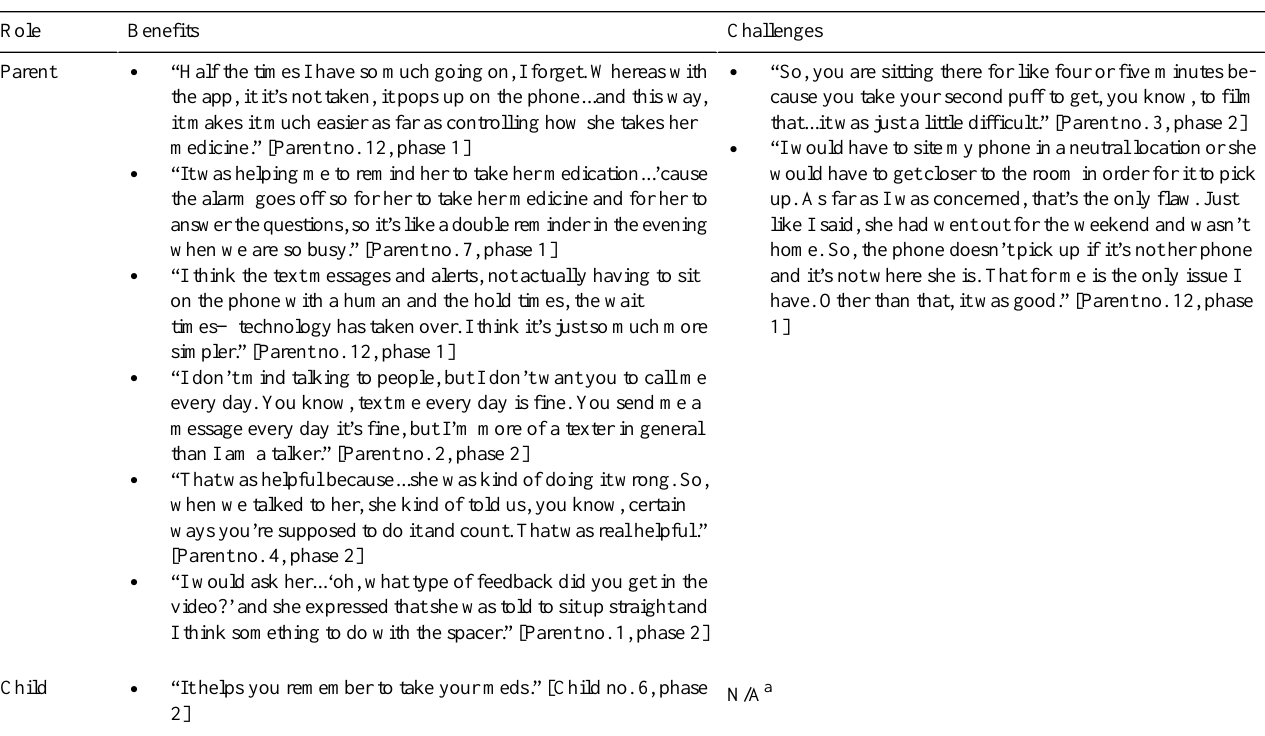
Table 4. Exemplar quotes on the benefits and challenges of Smartphone Asthma Management System.